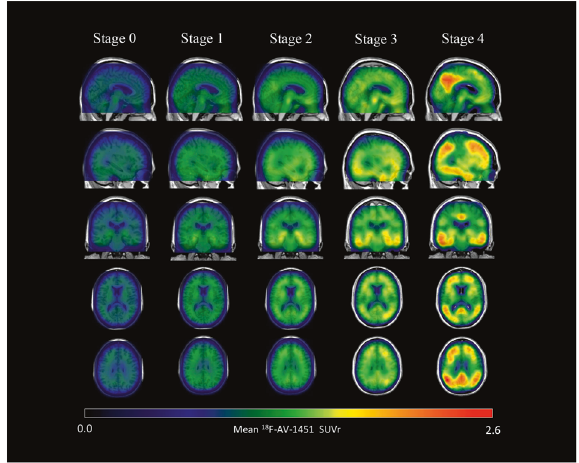
Fig. 1 Parametric 18 F-AV-1451 images across stages. In general, 18 F-AV-1451 SUVr increased throughout the cortex and subcortex from stage 0 to stage 4 (numerical values shown in Table 1). Participants in stage 0 had tau levels corresponding to those of normal young adults. A dominating tau elevation in medial temporal regions (Braak I/II ROIs) was shown in stage 1. While stage 2 presented increased SUVrs in extra-medial temporal regions, stage 3 showed greater SUVrs increase in Braak III/IV ROIs including inferior and lateral temporal lobes. Stage 4 had signi fi cantly elevated 18 F-AV-1451 SUVr extending into the neocortex. ROI region of interest, SUVr standard uptake value